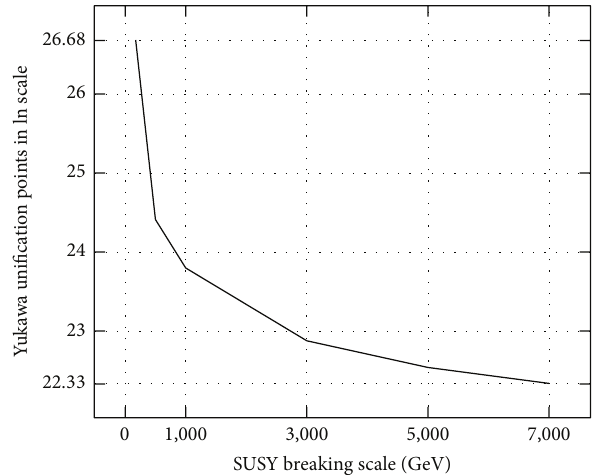
Figure 5: Nature of variation of Yukawa unification points with varying 𝑚 𝑠 .